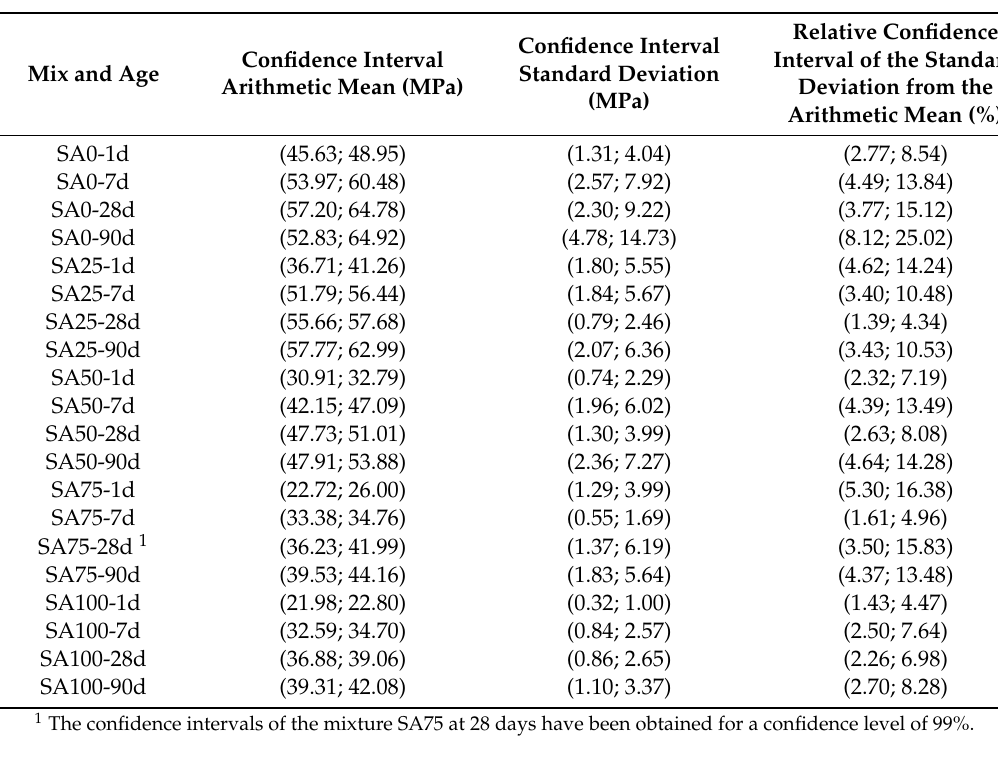
Table 10. Confidence intervals for mean and standard deviation of compressive strength for each mixture and age.